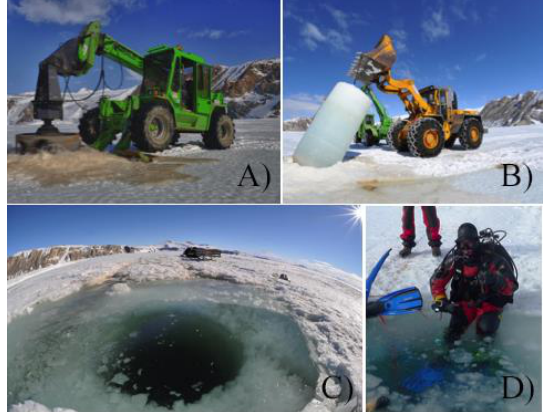
Figure 2. SCUBA-operated field activities in ice-coverage conditions: a hole is produced by an ice drillers in the pack ice (A), showing the thickness of ice coverage (about 3 m) (B). Through these holes (C) SCUBA-divers, adequately equipped, can access to -1.8°C cold polar waters